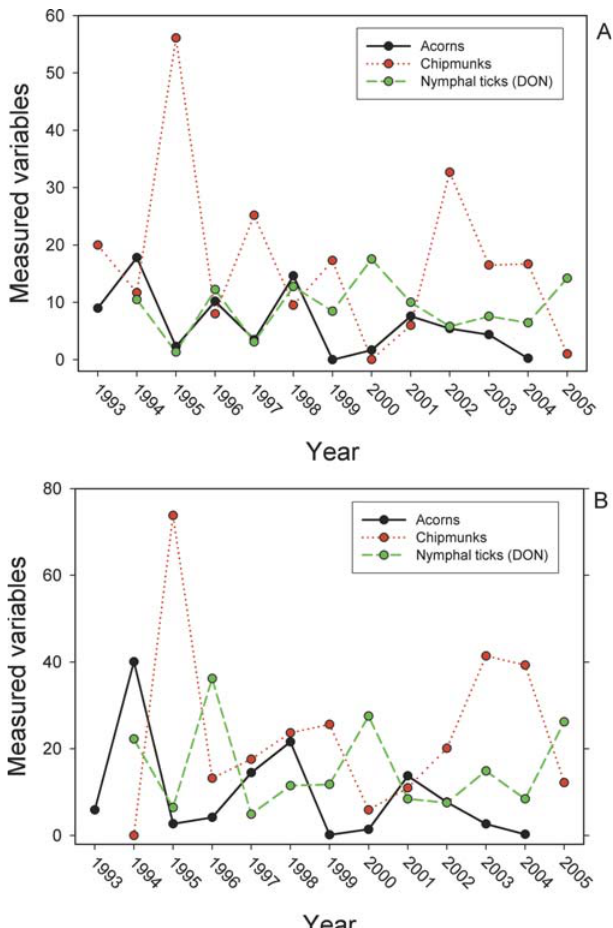
Figure 6. TimeSeriesofAcorn,Tick,andChipmunkDensitiesonStudyPlots Shows time series of acorn density (acorns per square meter), chipmunk density (number per 2.25-ha grid), and DON (number per 100 m 2 ) on the two longest-established study plots, Henry Farm (A) and Teahouse (B). Note that, typically, chipmunk density tracks acorn density with a 1-y lag, and DON tracks chipmunk density also with a 1-y lag. DOI: 10.1371/journal.pbio.0040145.g006